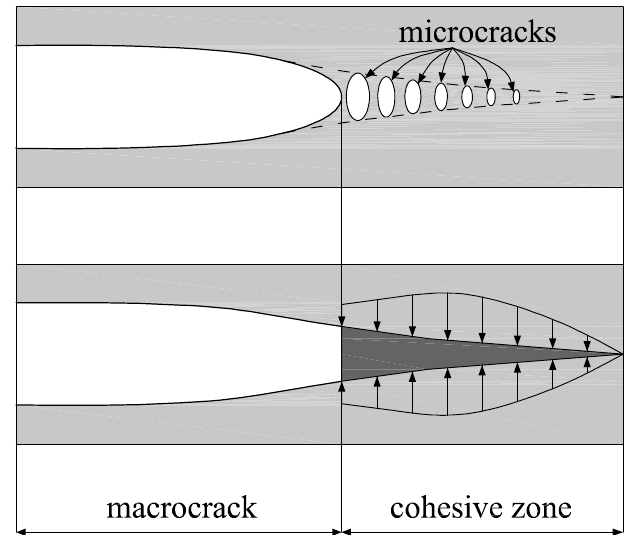
Figure 1. The basic of the cohesive zone model (redrawn based on the figure provided in